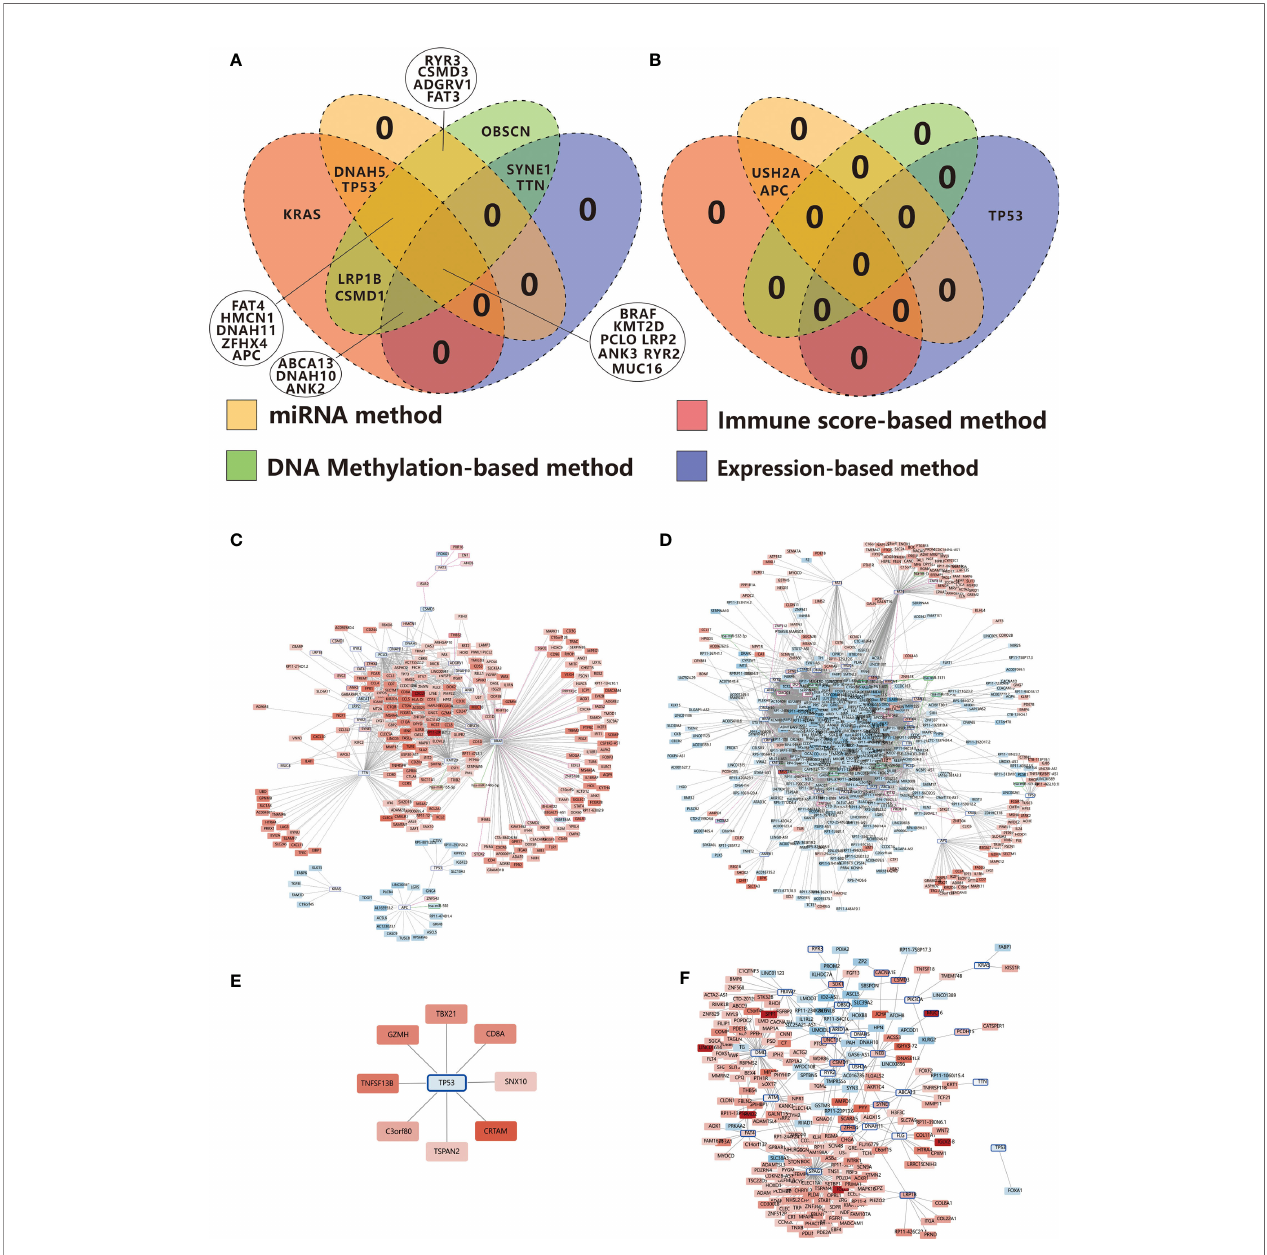
FIGURE 8 | Venn diagrams show the overlapping immune-related TMGs identi fi ed using the immune score-based method, gene expression-based method, miRNA target-based method, and DNA methylation-based method in RCC (A) and LCC (B) . (C) Positive correlation network centered on immune-related TMGs in RCC. (D) Negative correlation network centered on immune-related TMGs in RCC. (E) Positive correlation network centered on immune-related TMGs in LCC. (F) Negative correlation network centered on immune-related TMGs in LCC. The color strength represents the fold change of expression in the high-immunity group compared to that in the low-immunity group. Red indicates up-regulation while blue suggests down-regulation in the high-immunity group. The nodes with a blue edge represent TMGs, the nodes with no edge represent DEGs, the nodes with a purple edge represent the genes regulated by TMG-regulating DMPs while those with green edges represent